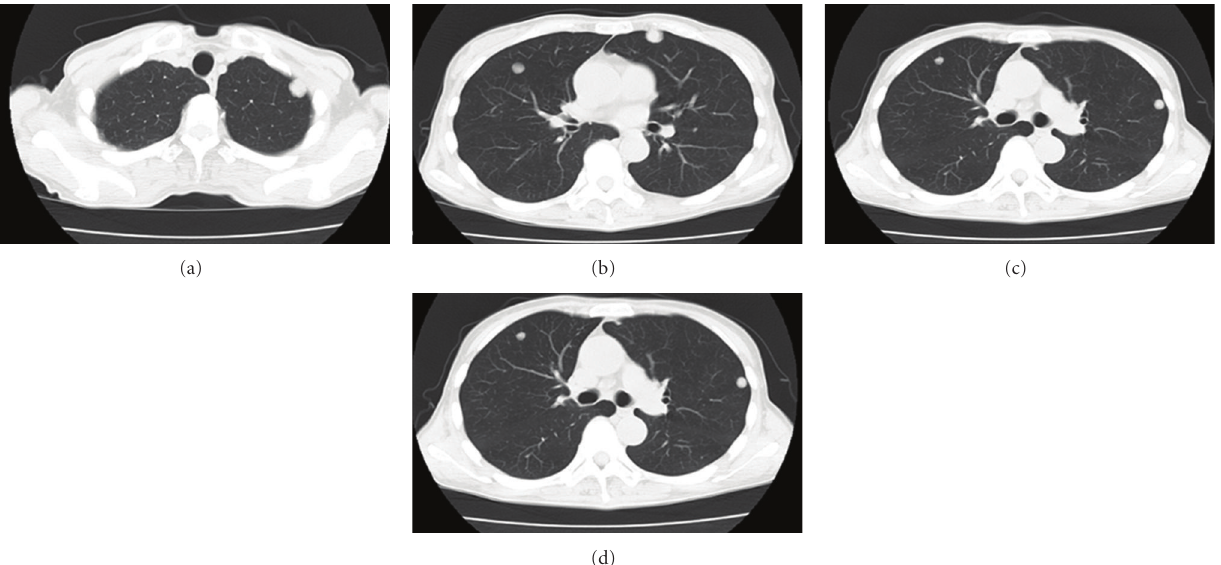
Figure 3: CT examination two months after CRS revealed rapid progression of multiple lung